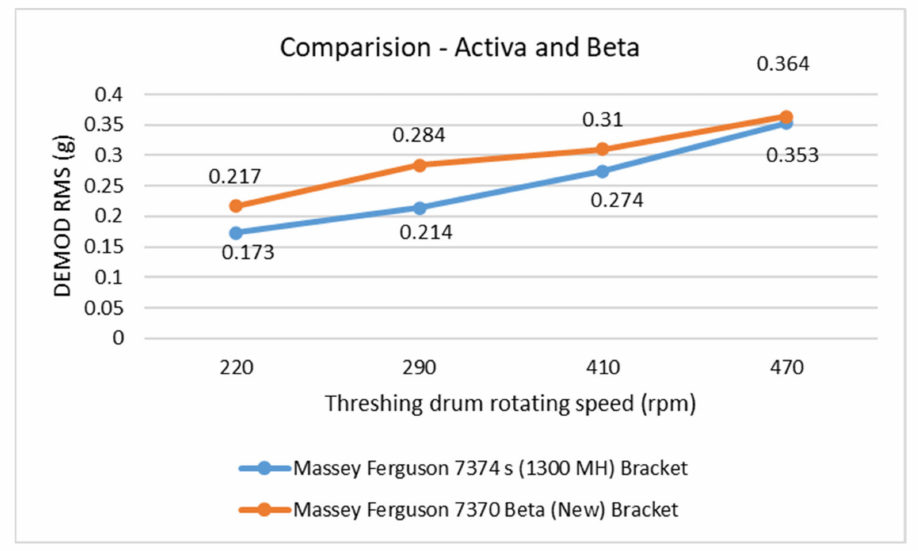
Figure 9. Comparison of the demodulated RMS value when the sensor is mounted on a bracket of the Beta and Activa versions at different threshing rotating